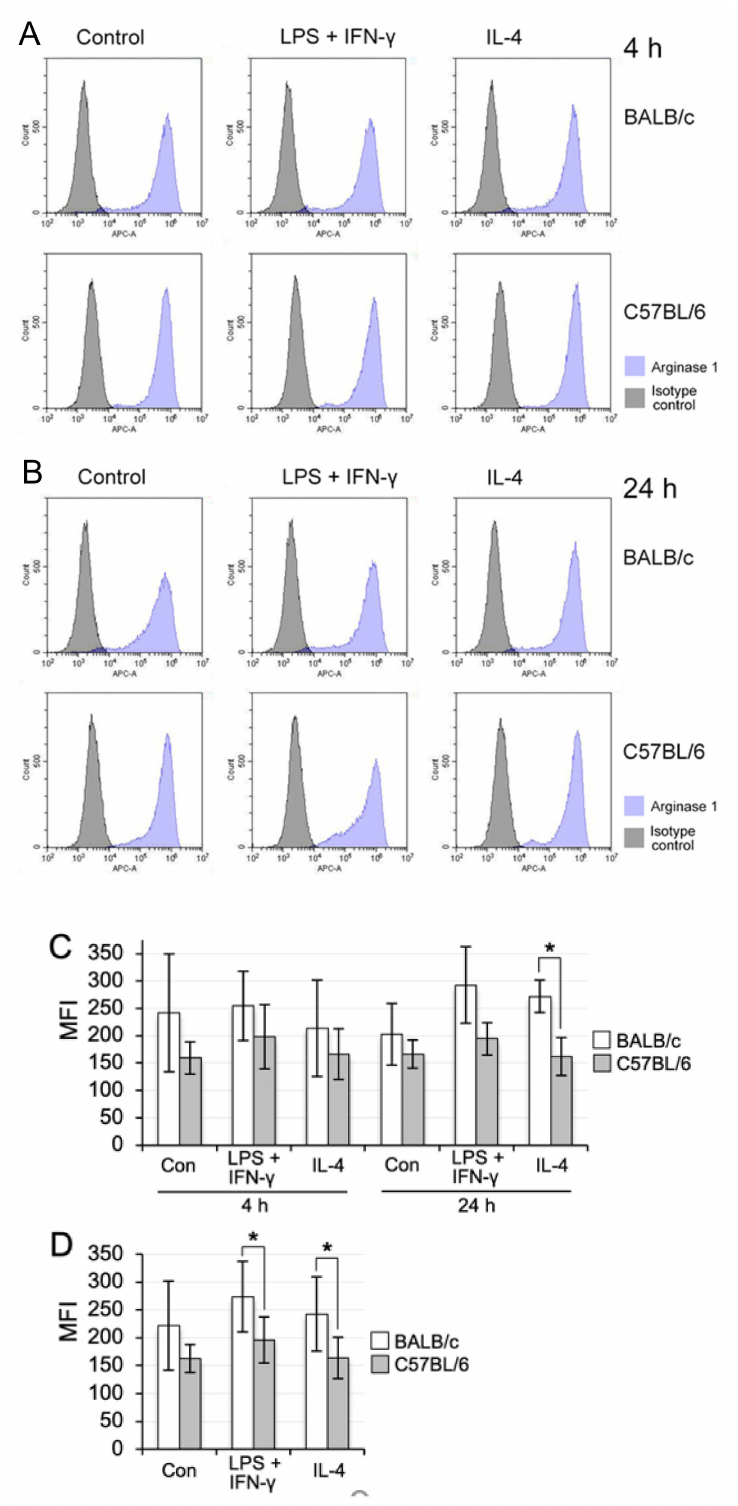
Figure 8. Comparison of the M2 polarisation property of BALB/c lung Mø propagated by co- culturing with that of C57BL/6 lung Mø. ( A , B ): Representative histograms from flow cytometric analyses showing the expression of arginase 1 in the propagated lung Mø of BALB/c mice and C57BL/6 mice treated with M1 (LPS plus IFN- γ ) and M2 (IL-4) polarisation inducer or without inducers (Control) for 4 h ( A ) and 24 h ( B ). Arginase 1 was expressed in lung Mø with or without treatment of the M1 and M2 inducers. The expression levels were similar in BALB/c lung Mø